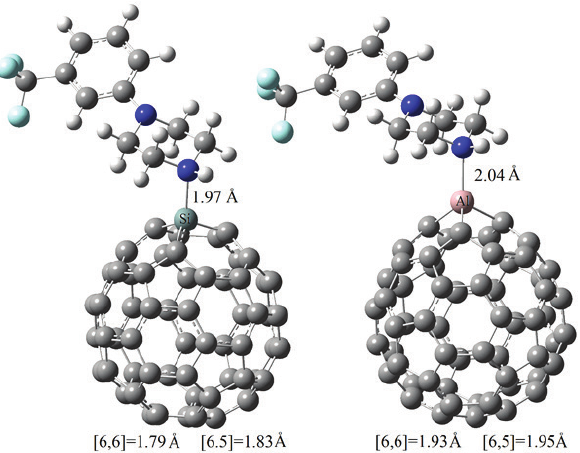
Table 1: Population analysis of N, Si and Al atoms for the examined structures.